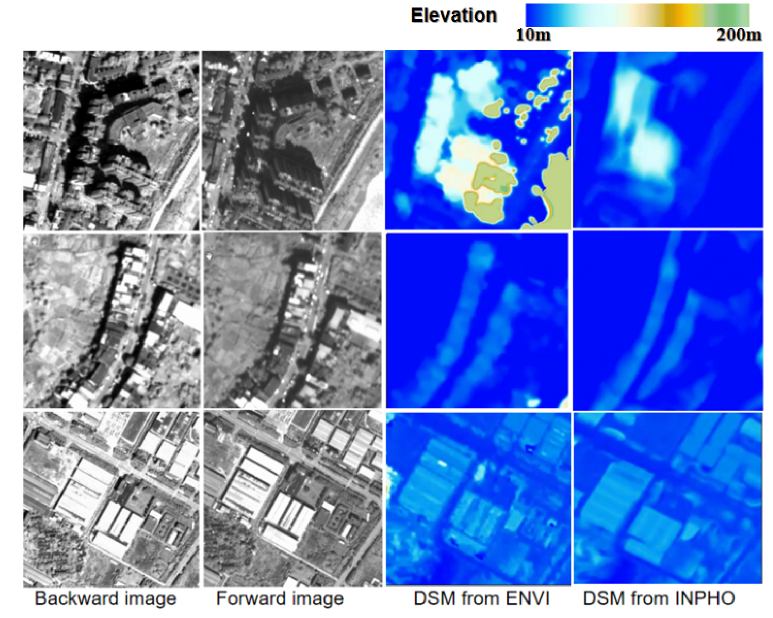
Figure 16. Epipolar image blocks and the DSM generated by ENVI and